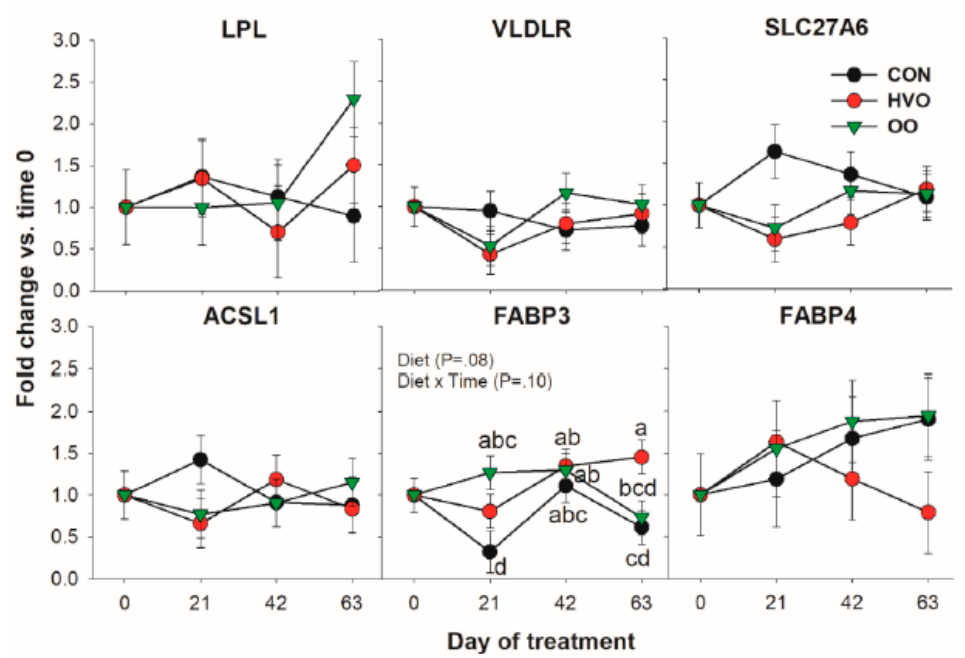
Figure 1. Effect of olive oil (OO) or hydrogenated olive oil (HVO) on transcripts coding for proteins involved in fatty acid transport and activation. Reported in the graph are the p -value of the overall effect of Diet and Diet × Time interaction. Diverse letters denote significant post-hoc differences ( p < 0.05).